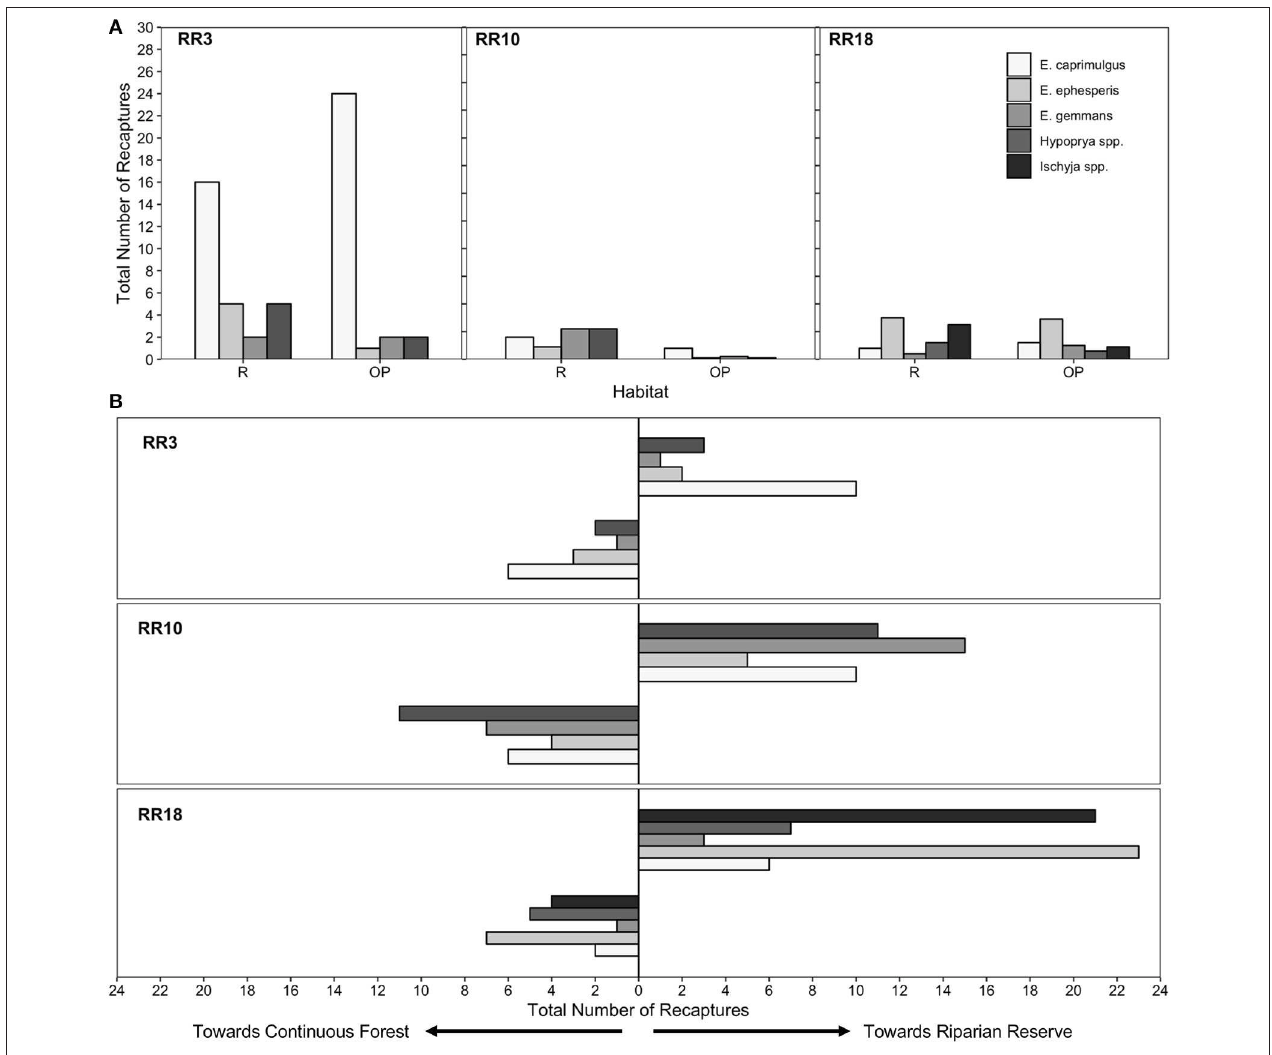
FIGURE 2 | Number of recaptures and orientation of movement for moths. (A ) Total number of recaptures for each species in each habitat in each site. (B) Total number of movement orientations for each species toward riparian forest or toward continuous forest (VJR) in each site. Bars are shaded based on taxon.